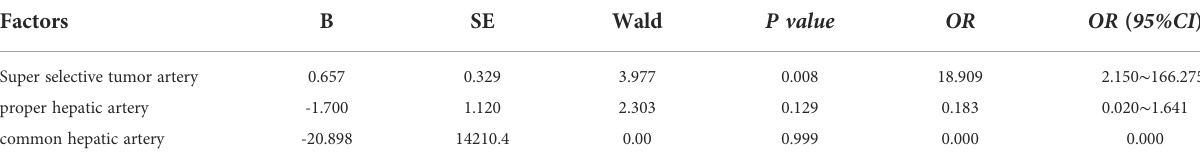
TABLE 6 Binary regression analysis on the relationship between the injection of Licartin into the artery and the increase in the distribution of Licartin. Factors